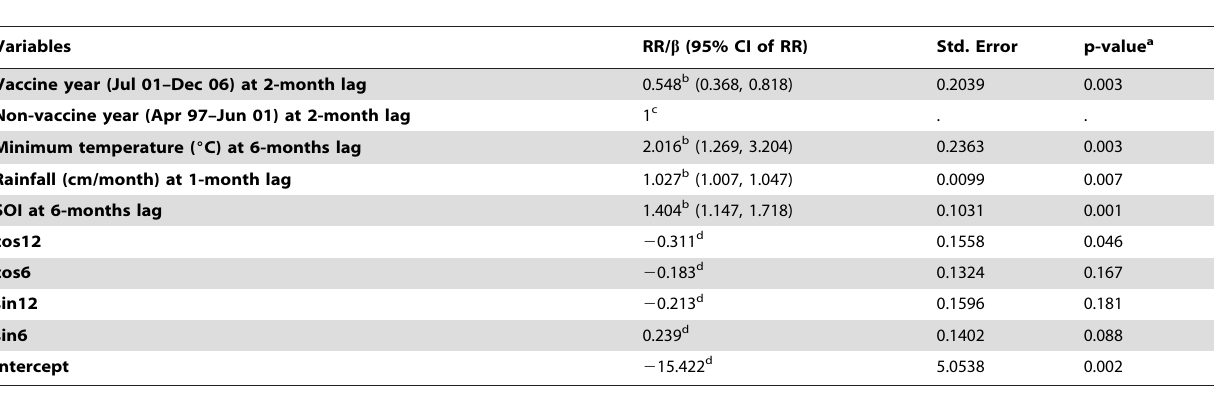
Table 2. Multivariable estimate of the JE risk ratio for vaccine coverage year, different weather variables and Southern Oscillation Index (SOI), controlling for seasonal periodicity using Poisson regression.